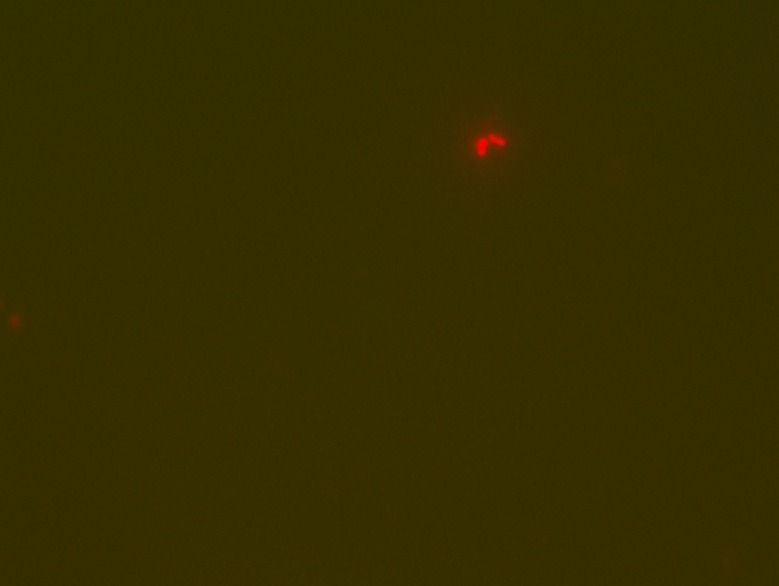
EDTA demineralised Late Cretaceous surface eroded fossil bone at 691 m elevation in Dinosaur Provincial Park showing possible cell clusters as might be expected in a biofilm (image 3).Sample ID as in Appendix 1—table 2: 16B.